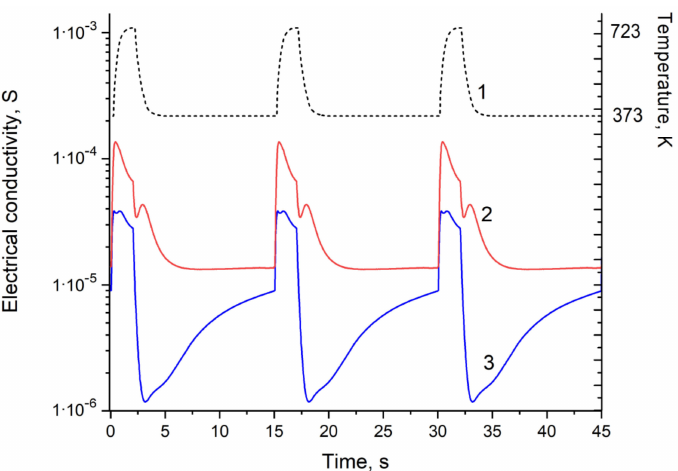
Figure 1. Change in temperature (1) and electrical conductivity of the MOX sensor at 100 ppm hydrogen (2) and 100 ppm carbon monoxide (3) in the air over three measurement